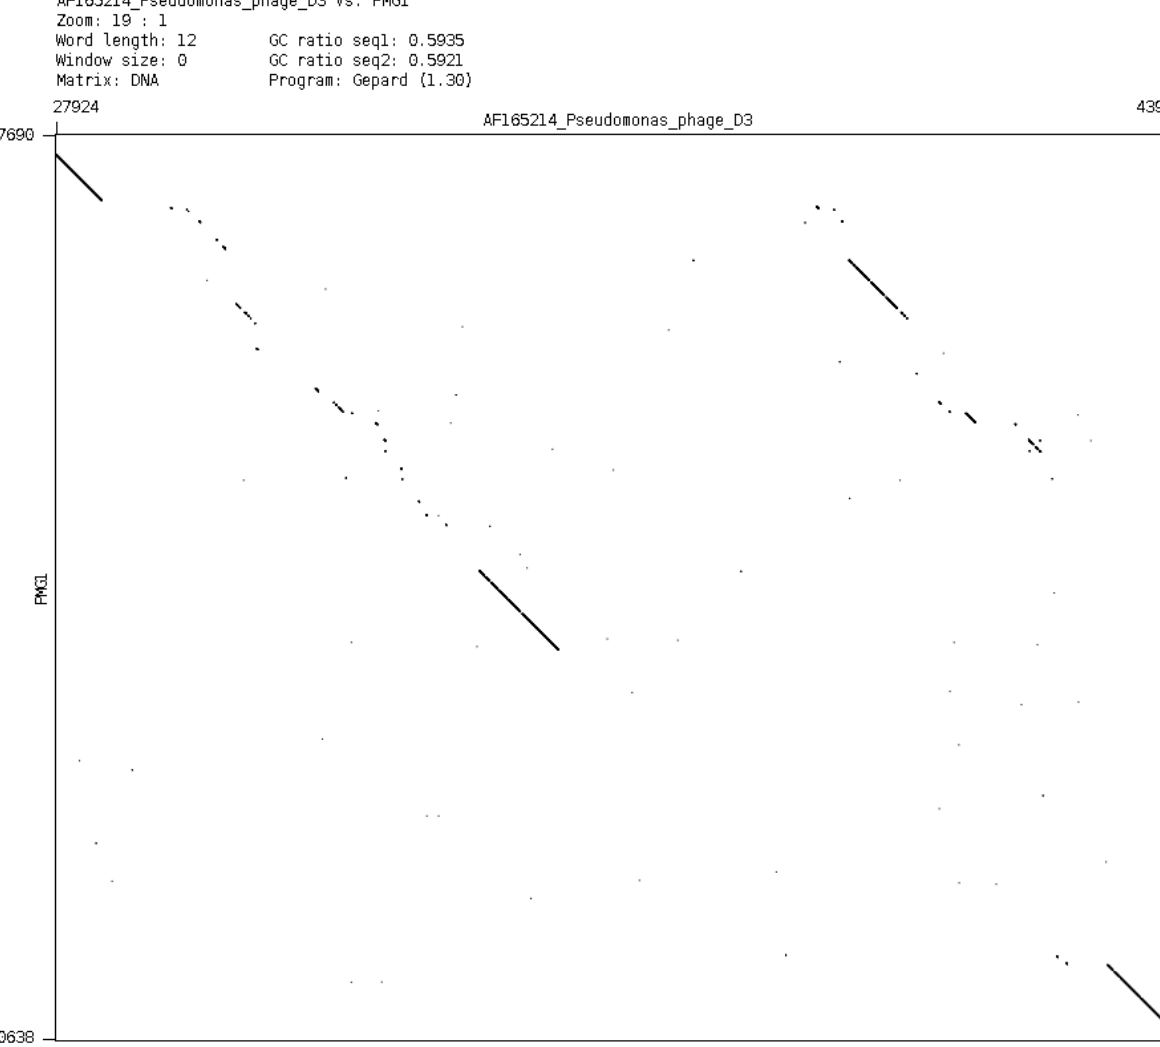
Figure 6. Comparison of phage genomes phiPMG1 and D3 (with Dot-plot program GEPARD) shows the complicated rearrangements in phiPMG1 genome regulatory region. phiPMG1 produces repressor but there are no stable